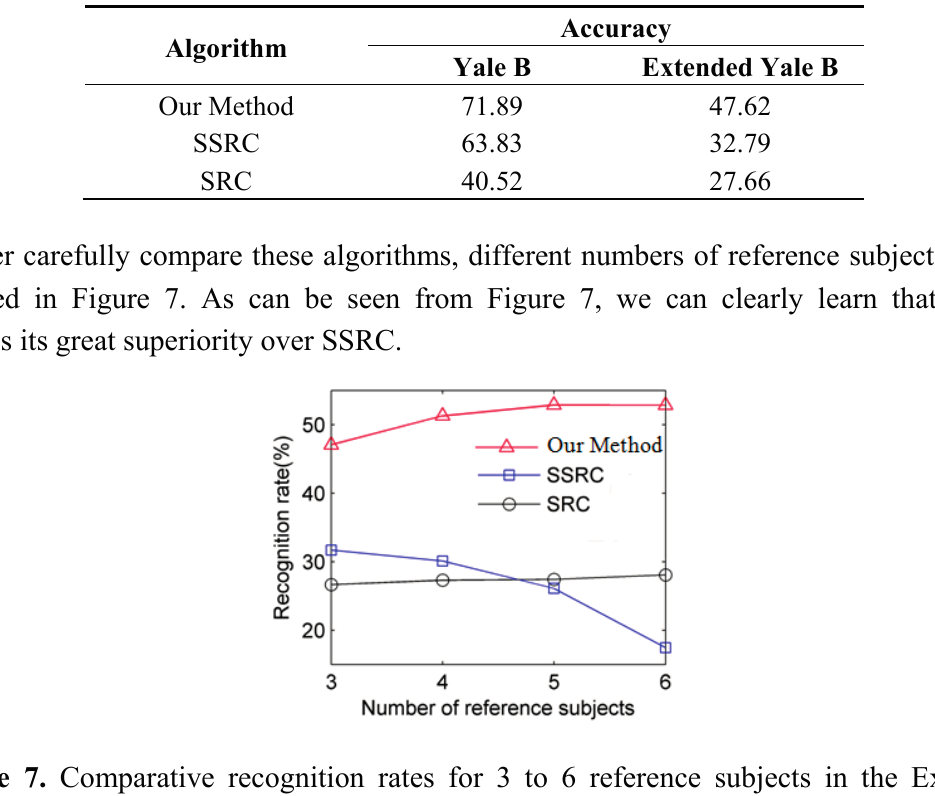
Figure 7. Comparative recognition rates for 3 to 6 reference subjects in the Extended Yale B dataset.